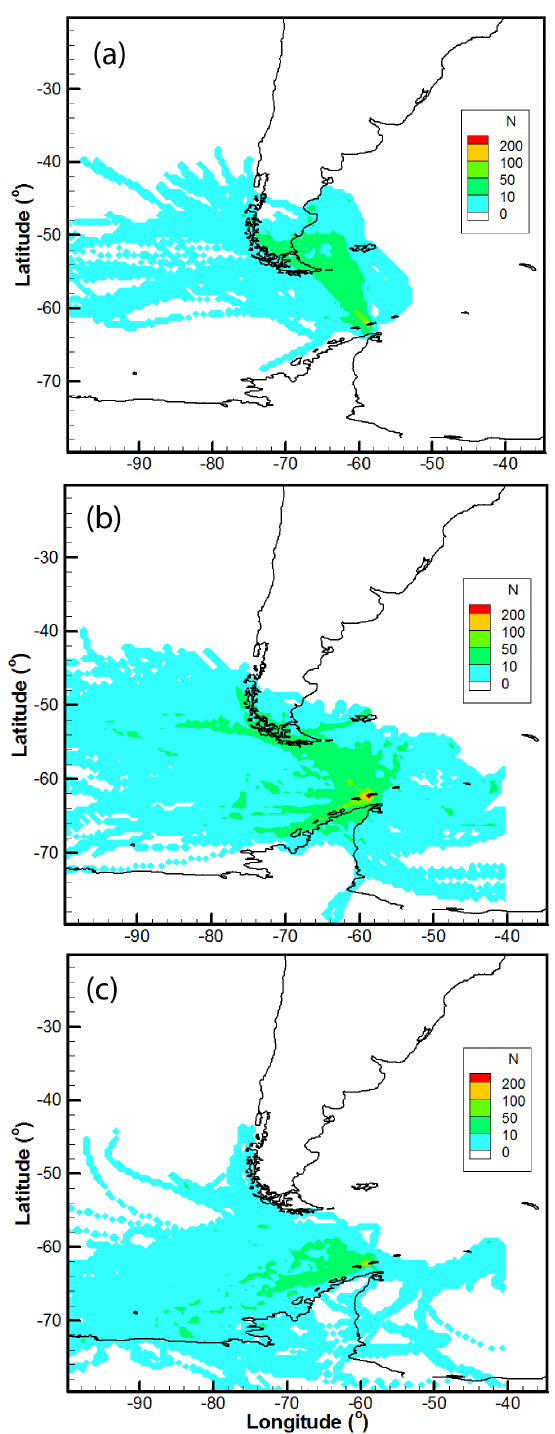
Figure 7. Trajectory density plots of (a) high-radon events ( > 400mBqm − 3 ) , (b) intermediate radon events (100– 400mBqm − 3 ) and (c) least terrestrially perturbed events. Here “N” represents the number of times a trajectory passes through a 0.5 ◦ × 0.5 ◦ grid